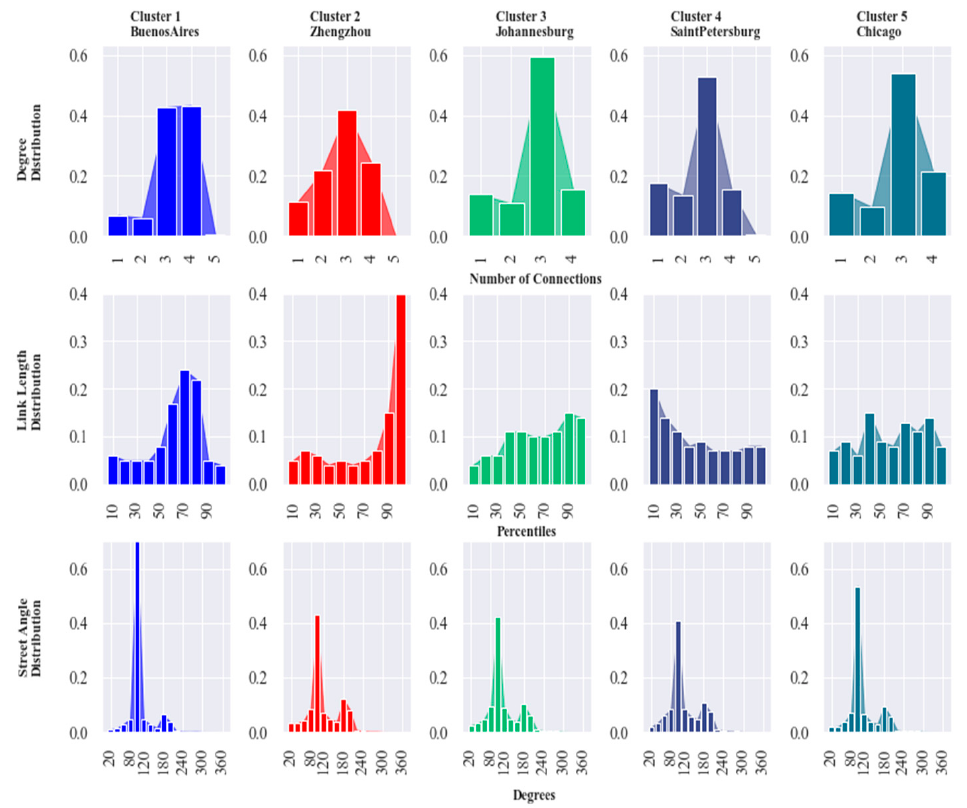
Figure 4. Distributions of cities representative of each class. Figure 3. Distributions of cities representative of each